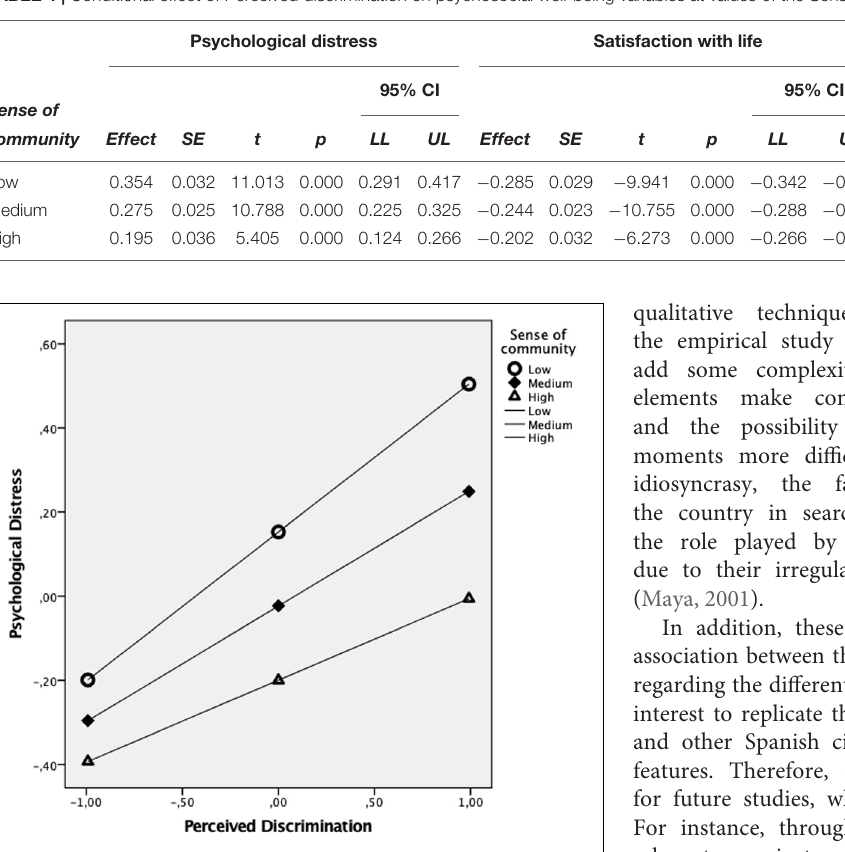
FIGURE 2 | Conditional effect of perceived discrimination on psychological distress at values of sense of